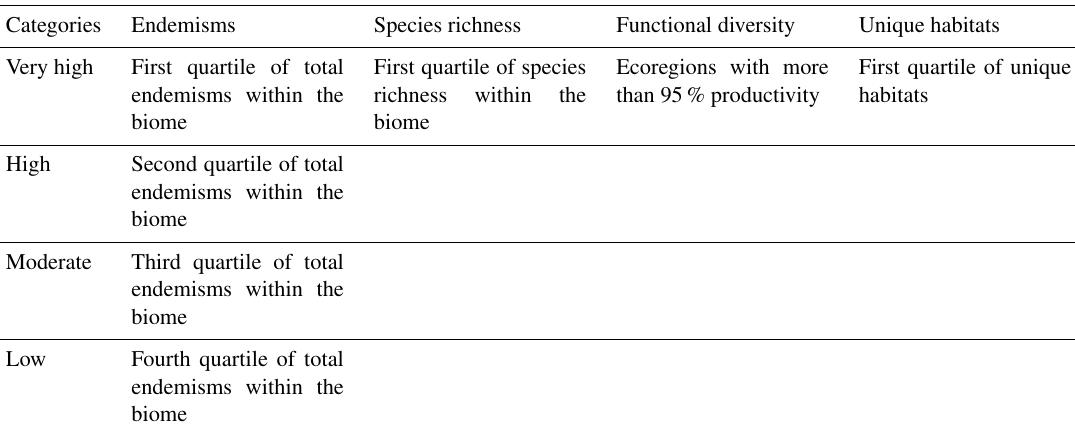
Table 2. Summary of the criteria for assigning ecoregions within the biomes to the different categories. Categories Endemisms Species richness Functional diversity Unique habitats Ecoregions with more First quartile of unique First quartile of species Very high First quartile of total than 95% productivity richness within the biome biome